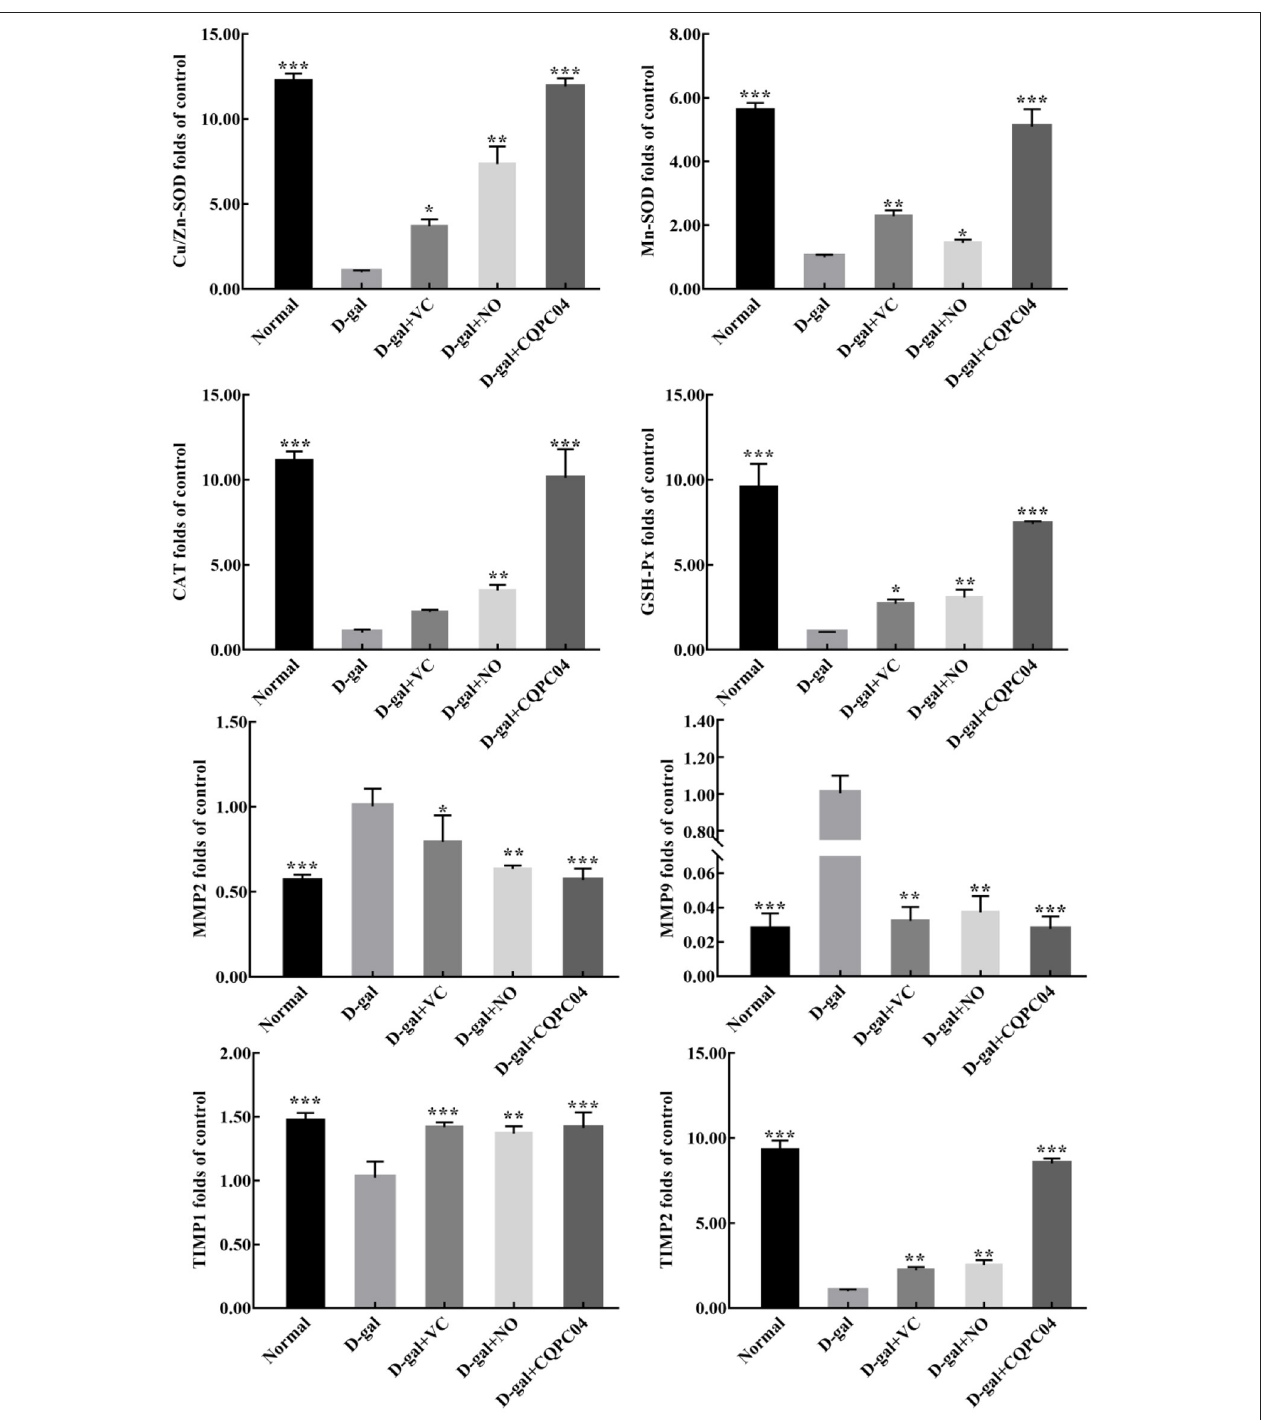
FIGURE 7 | mRNA expression of Cu/Zn-SOD, Mn-SOD, CAT, GSH-Px, MMP2, MMP9, TIMP1, and TIMP2 in skin. D-gal: mice fed the standard chow diet plus drinking water with intraperitoneal injection of D-galactose (120 mg/kg of BW); D-gal + VC: vitamin C (100 mg/kg of BW) plus intraperitoneal injection of D-galactose (120 mg/kg of BW); D-gal + NO: non-fermented soy milk (0.1 mL/10g of BW) plus intraperitoneal injection of D-galactose (120 mg/kg of BW); D-gal + CQPC04: L. fermentum CQPC04-fermented soy milk (0.1 mL/10g of BW) plus intraperitoneal injection of D-galactose (120 mg/kg of BW). * p < 0.05, ** p < 0.01, and *** p < 0.001 compared to D-gal